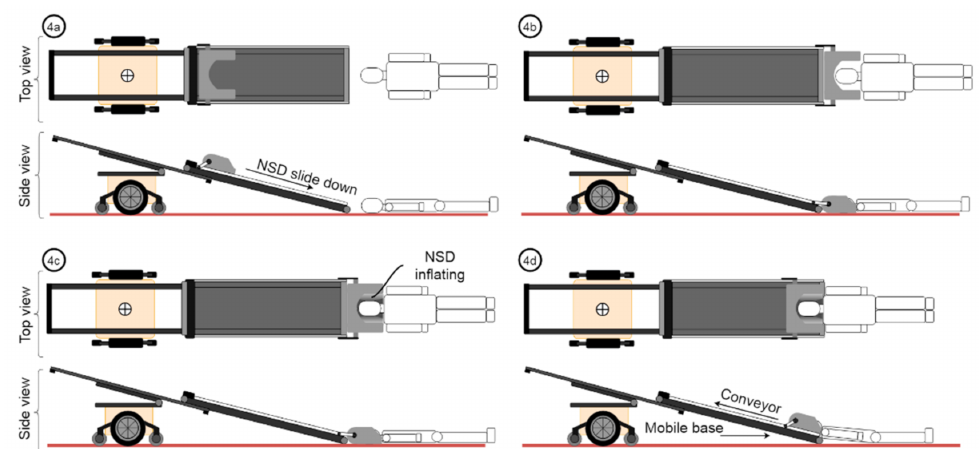
Figure 8. Illustration of the updated procedure to load casualties by means of the NSD system. This procedure is an extension of Step 4 in Figure 6. ( 4a ) Once the robot achieves the desired loading configuration, the NSD module is sliding down, approaching the casualty. ( 4b ) The NSD frame is placed in the desired position so that the casualty’s head and neck are in the NSD frame centre. ( 4c ) The inflatable system of the NSD then slowly inflates and stabilises the casualty’s head and neck. ( 4d ) Initiating the casualty loading process by synchronising the movement of the base and the motion of the belt